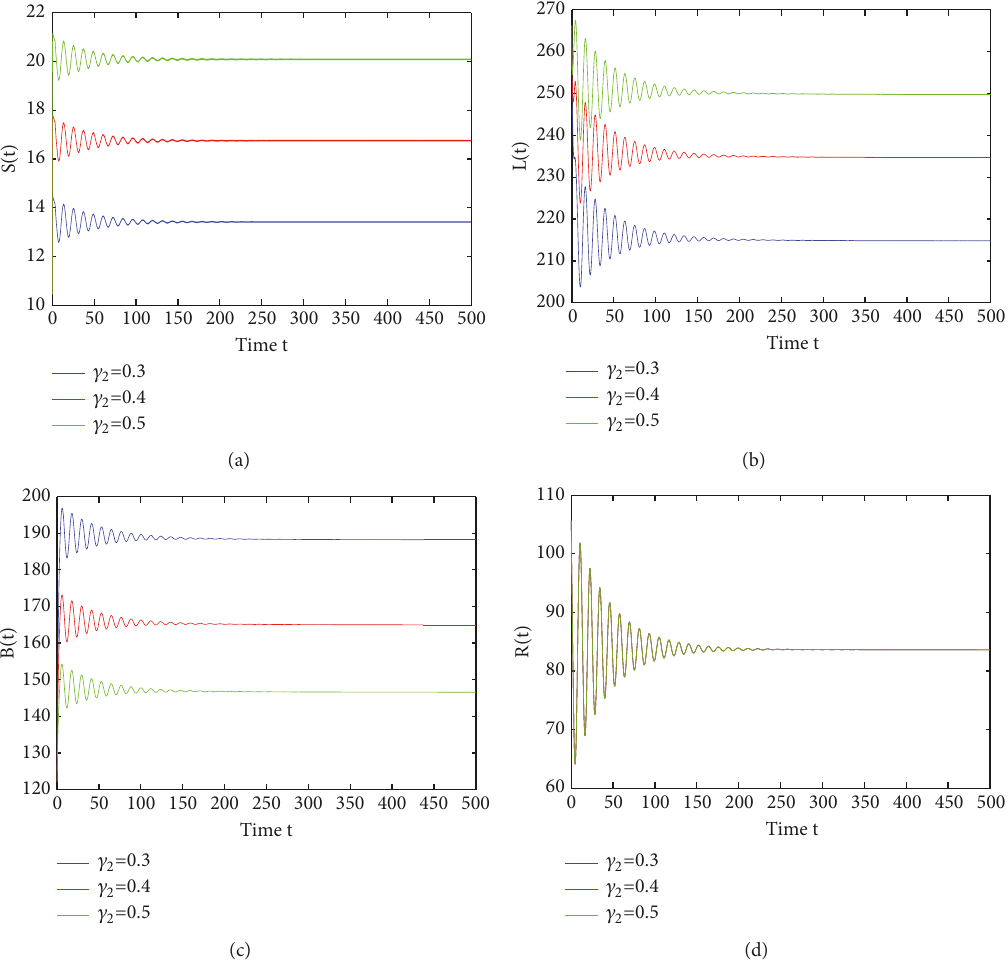
Figure 9: Time plots of 𝑆 , 𝐿 , 𝐵 , and 𝑅 for different 𝛾 2 at 𝜏 = 3.2575 . Rest of the parameters are taken as given in the